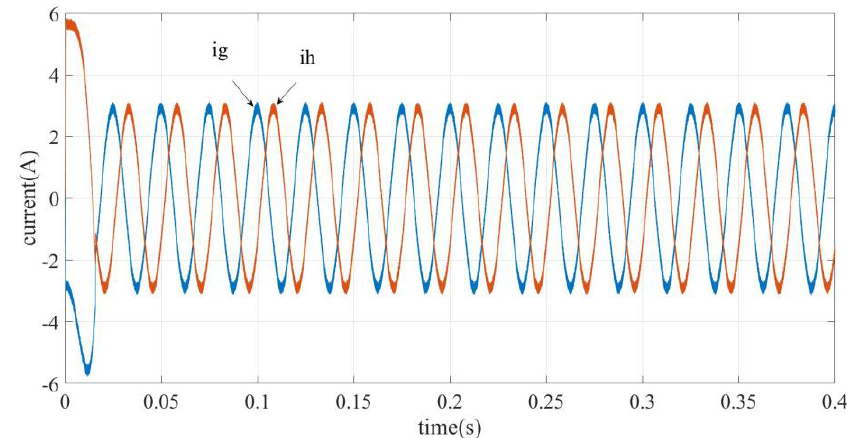
Figure 9. The g -axis and h -axis currents when the motor is under load.